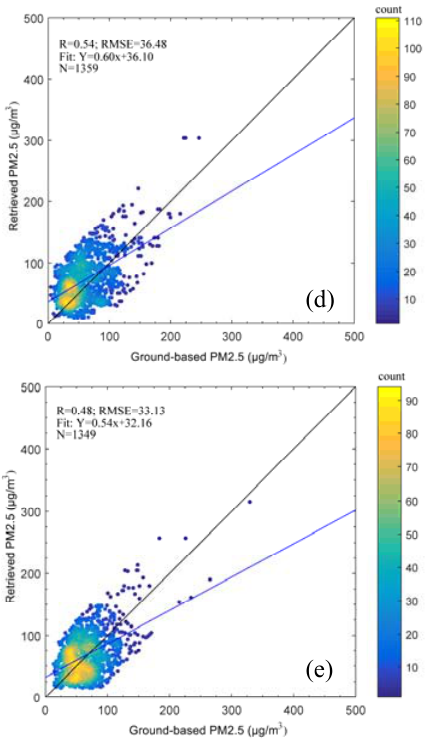
Figure 1. Density scatter plots of retrieved versus ground-based PM 2.5 in (a) Beijing, (b) Shijiazhuang, (c) Tangshan, (d) Nanjing, (e) Changsha. The statistics from a linear least square fit the data points are shown in the upper left corners, with their corresponding equations, correlation coefficient ( R ), the root mean square error (RMSE) and total number of observations ( N ). The colours of dots represent density distribution of matches. The blue solid line is the regression line from two datasets and the black solid line represents identity